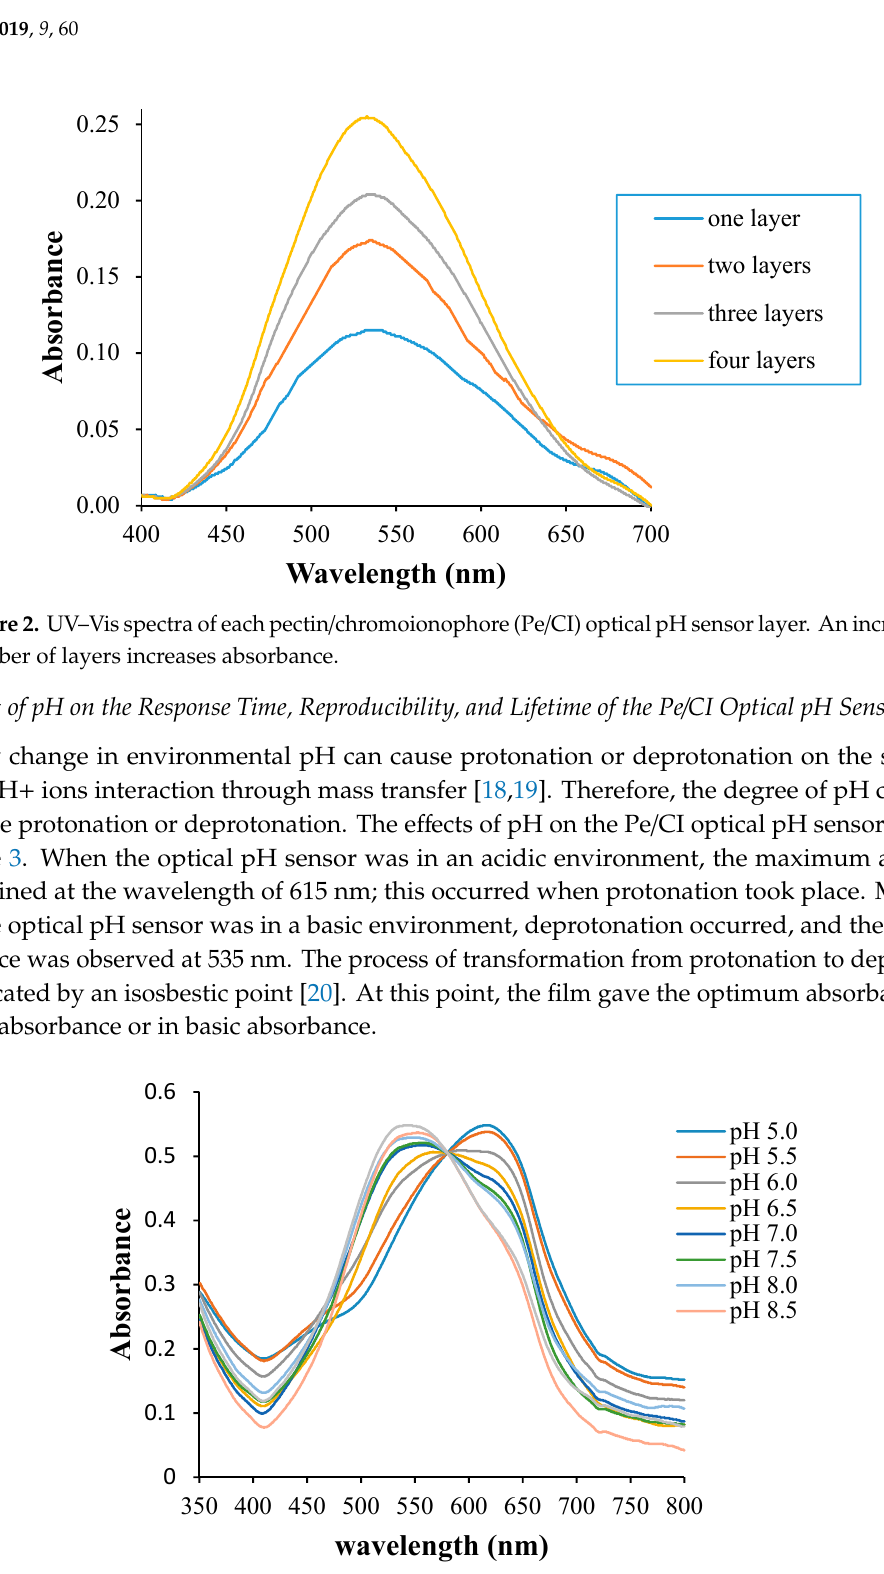
Figure 3. The response of the Pe / CI optical pH sensor to variations in pH in a PBS 10 mM solution, showing conversion from the protonated to the deprotonated form.